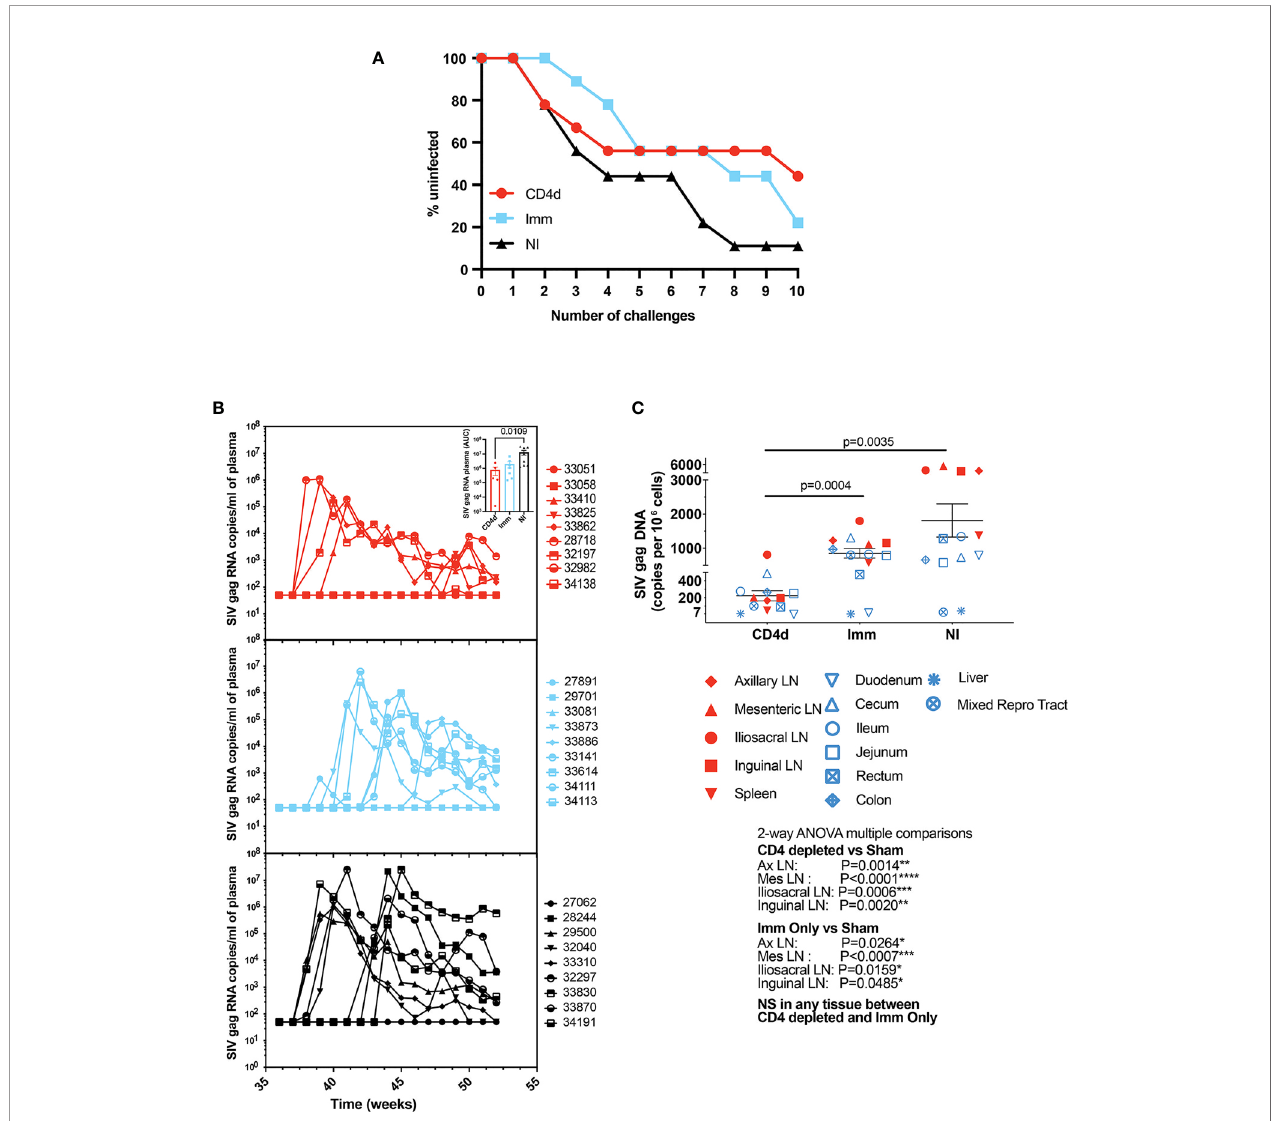
FIGURE 5 | CD4 depletion during priming phase reduces risk of infection. (A) Rhesus macaques were challenged intrarectally with increasing doses of SHIV-BaL virus. Survival curves showing CD4 depletion reduces risk of infection. (B) RT-PCR was used to quantitate viral SHIV-BaL RNA in plasma. (C) Assessment of tissue- related virus (copies per million cells). Red = CD4 depleted (CD4d) group, turquoise = Immunized (Imm) group, black = Non-Immunized (NI) group. Signi fi cant difference (p < 0.05) between groups as determined by two-tailed t-test and 2-way ANOVA, *p < 0.05, **p <0.005, ***p < 0.001, ****p <